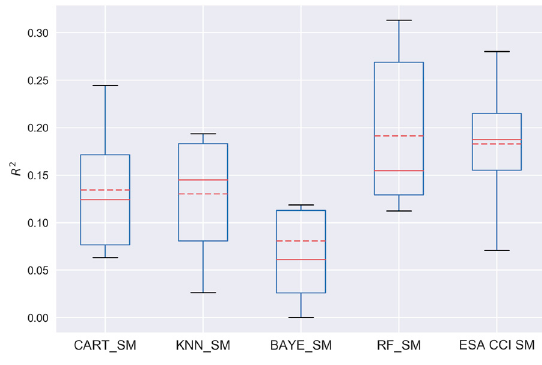
Figure 7. Box plot of R 2 .